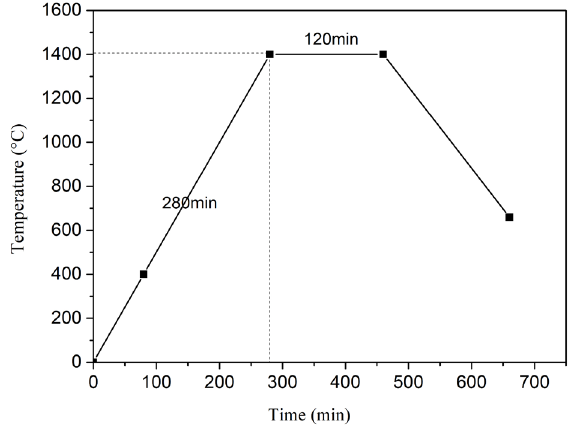
Figure 3. Temperature curve of the tube furnace.